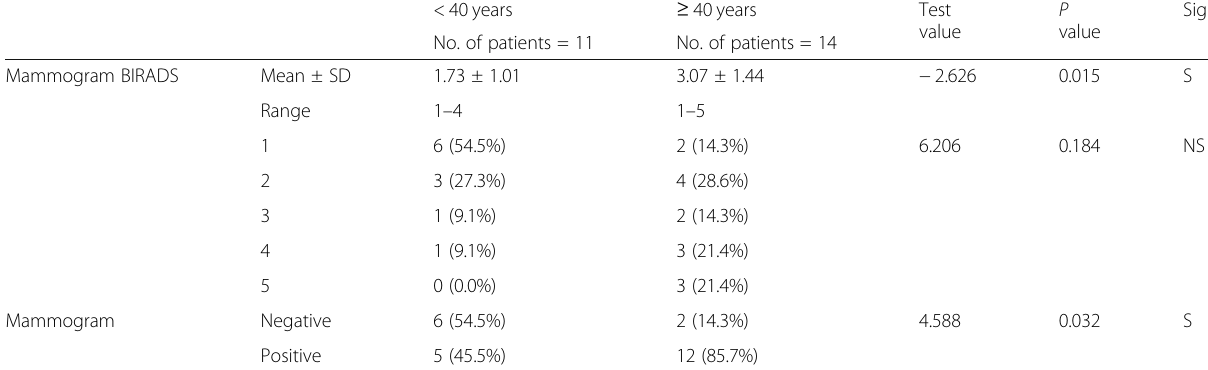
Table 9 Comparison between detected lesions and correlated BIRADS by mammogram with patient's